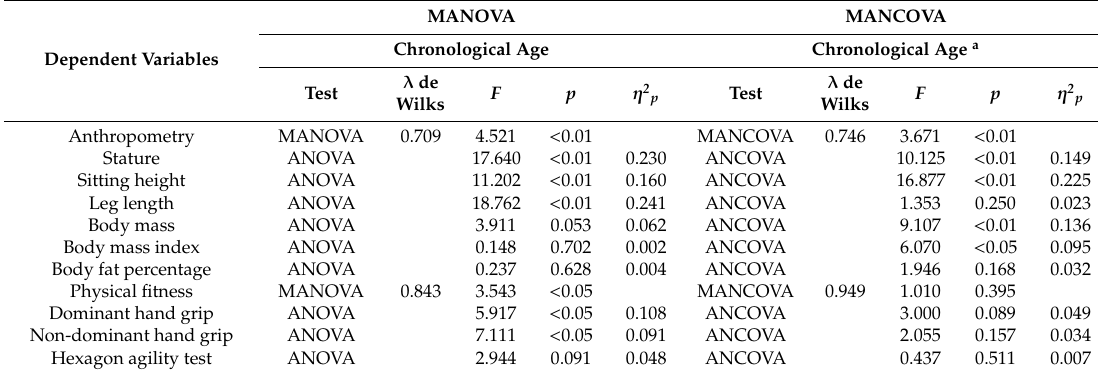
Table 2. Multivariate analyses of variance (MANOVA) and multivariate analyses of covariance (MANCOVA) with somatic maturation given by z-scores of the attained predicted adult stature as the covariate) to examine the e ff ects of chronological age on anthropometry and physical fitness.